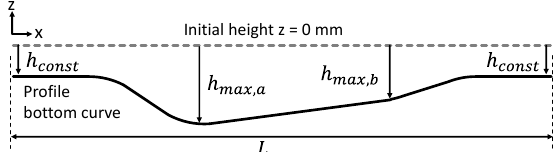
Figure 7. Geometric characteristics of the target profile bottom curve.